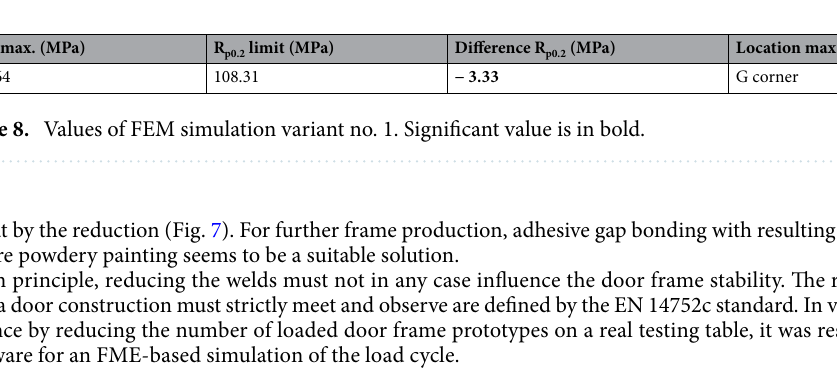
Figure 7. Drawing with detail of the corner of a door frame with reduced welds.